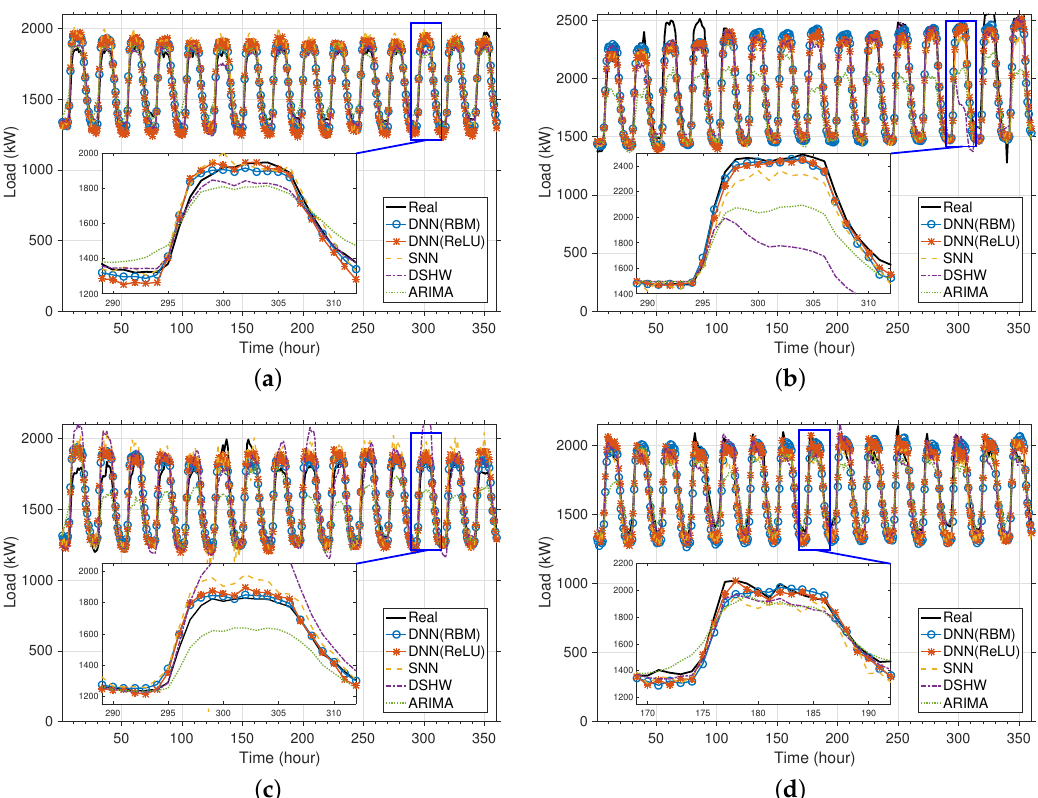
Figure 12. Seasonal prediction results: ( a ) spring; ( b ) summer; ( c ) fall; ( d ) winter. SNN, shallow neural network; DSHW, double seasonal